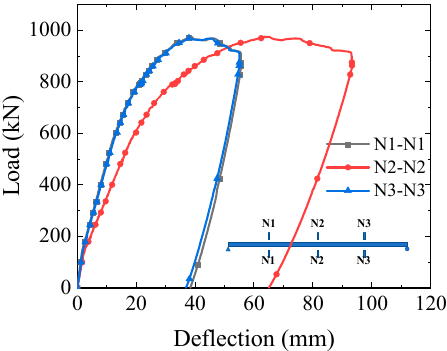
Figure 7. Load–deflection curves at mid-span and quarter-span.